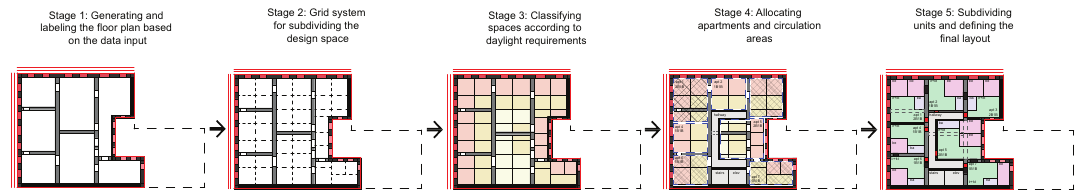
Figure 5. Summary of the Reviver grammar process.